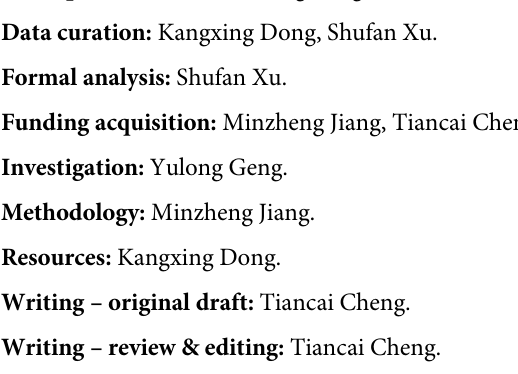
S1 Table. Working parameters of submersible screw pump. S2 Table. Part of the data of the fault diagnosis